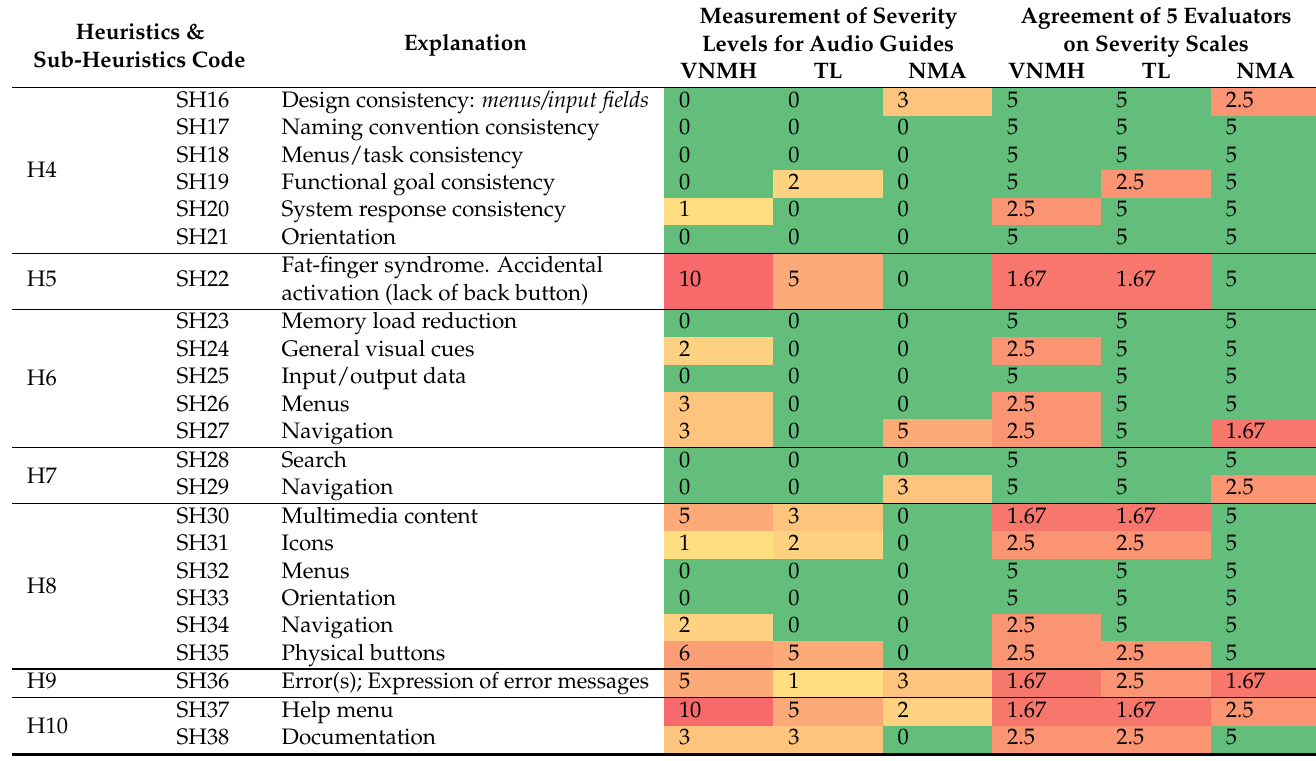
Table 3. Measurement of severity levels for websites (left heat map with red is the highest and green is the lowest values); and the agreement of five evaluators on severity scales (right heat map with red is the lowest and green is the highest values). Heuristics & Sub-Heuristics